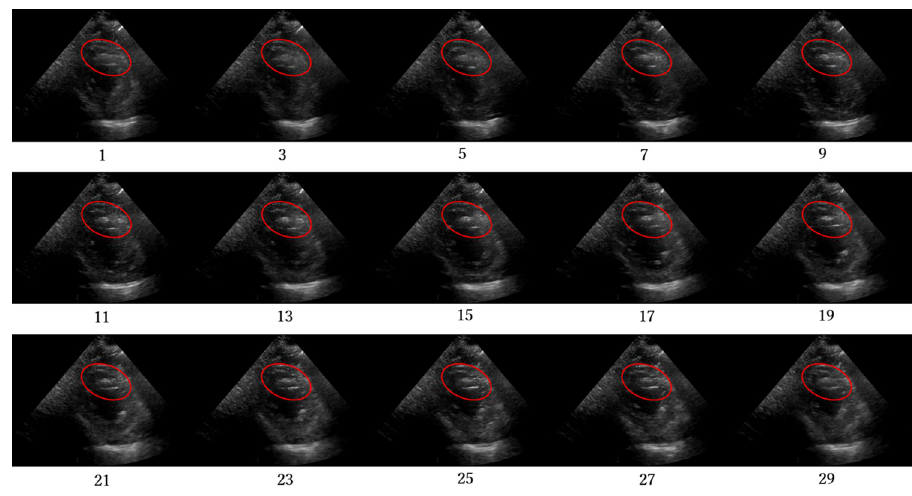
Fig 22. False-negative cases on short-axis view papillary muscle level